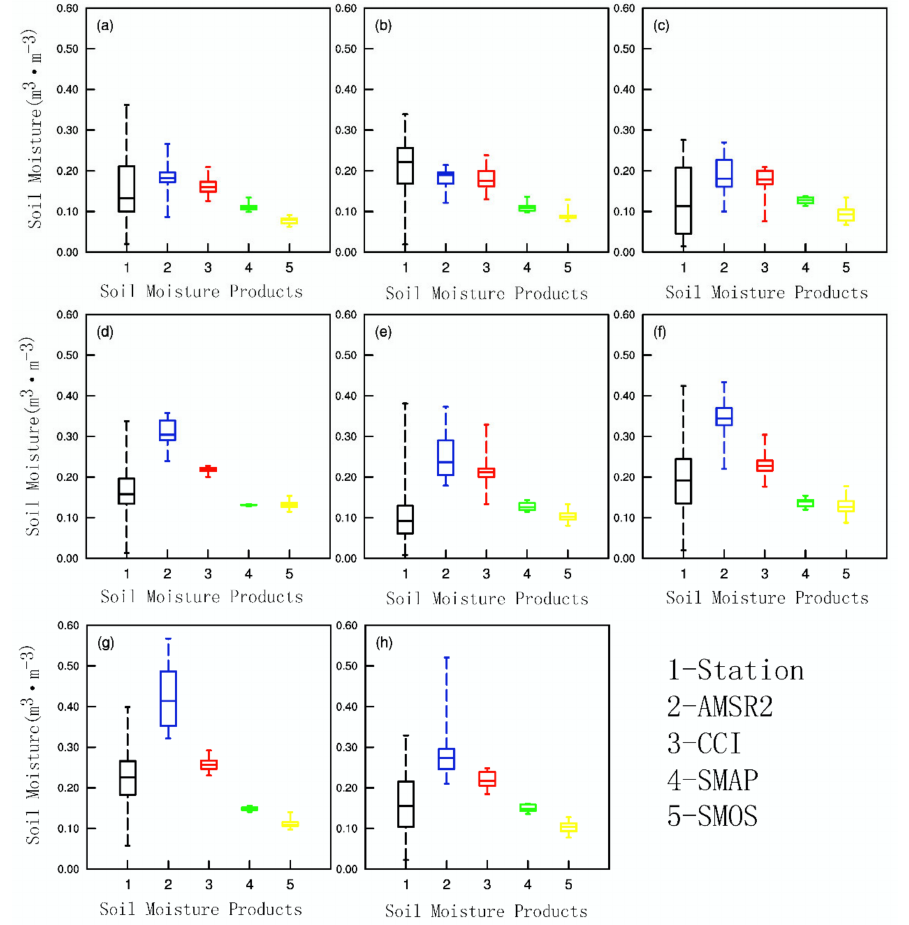
Figure 8. Box plots of average values of soil moisture observation and retrieval stations in represen- tative regions ( a ) C1 (northern Xinjiang); ( b ) C2 (southern Xinjiang); ( c ) C3 (Hexi Corridor); ( d ) C4 (Qinghai–Tibet Plateau Slope); ( e ) C5 (northern Loess Plateau); ( f ) C6 (North China Plain); ( g ) C7 (eastern Northeast Plain); ( h ) C8 (western Northeast Plain). Table 3. Retrieval deviations of soil moisture products in different climate zones (unit: m 3 · m − 3